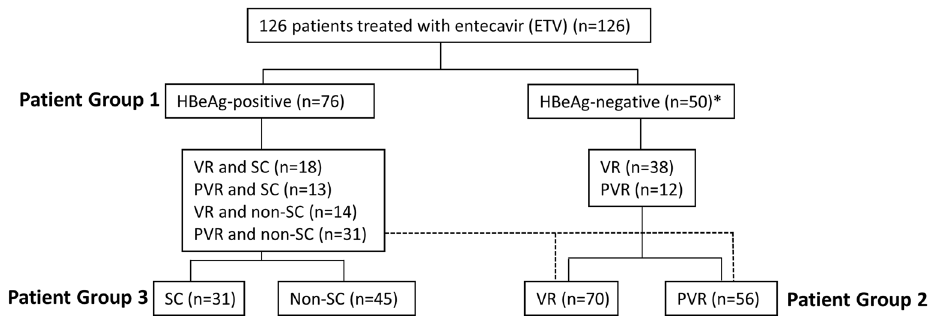
Figure 1. Treatment-naïve chronic hepatitis B patients treated with entecavir (ETV) and treatment outcome. All patients (n = 126) were treated with entecavir for 22–87 months. Three patient groups were used, HBeAg- positive vs. HBeAg-negative; VR, virological response vs. PVR; and SC, seroconverters vs non-SC, no seroconversion. Asterisk, HBeAg-negative patients were anti-HBe antibody positive before the treatment.